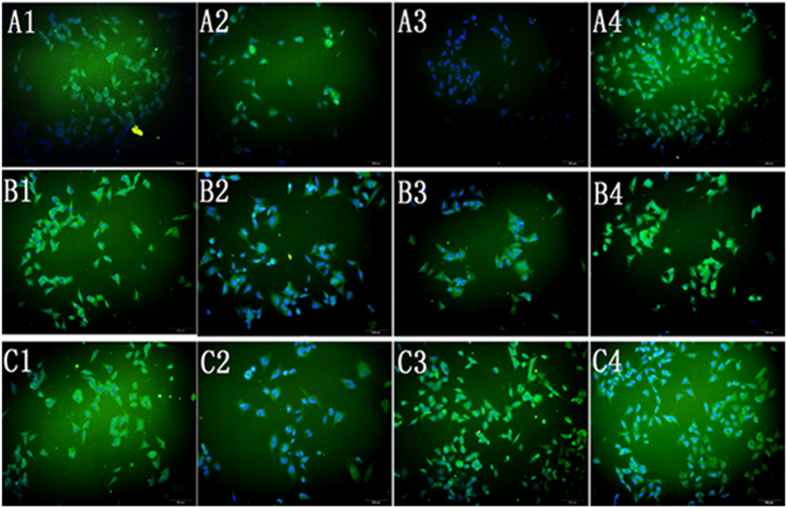
Immunofluorescence provides information about protein expression and localization.(A1–A4) Expression of HIF-1α protein in the blank, MEG3 OE, HCN3 KD and linc01105 KD groups. (B1–B4) Expression of Noxa protein in the blank, MEG3 OE, HCN3 KD and linc01105 KD groups. (C1–C4) Expression of Bid protein in the blank, MEG3 OE, HCN3 KD and linc01105 KD groups.